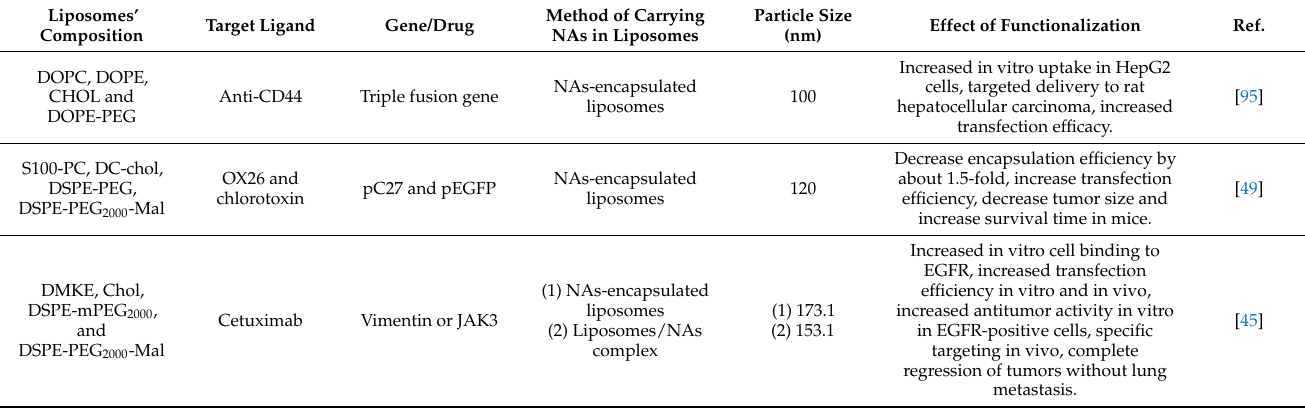
Table 4. List of studies that used liposomes for active targeting nucleic acids to tumoral cells and the effect of functionalization in cancer